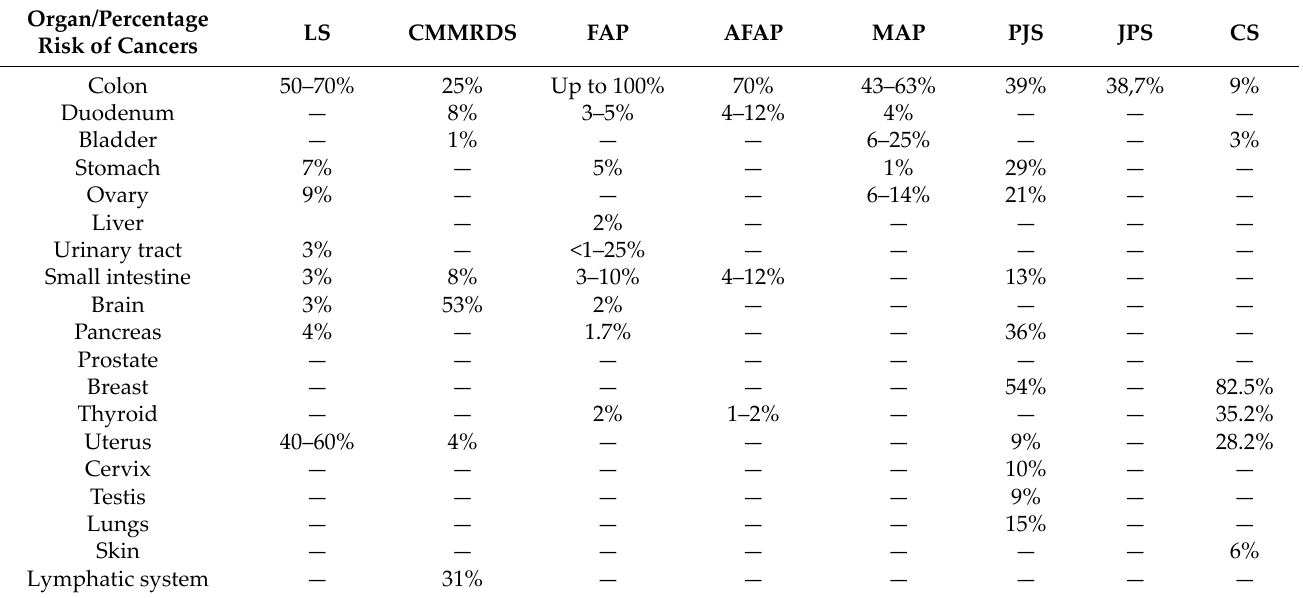
Table 3. Percentage risk of cancers associated with hereditary syndromes [15,134,154,170,172,192– 196].